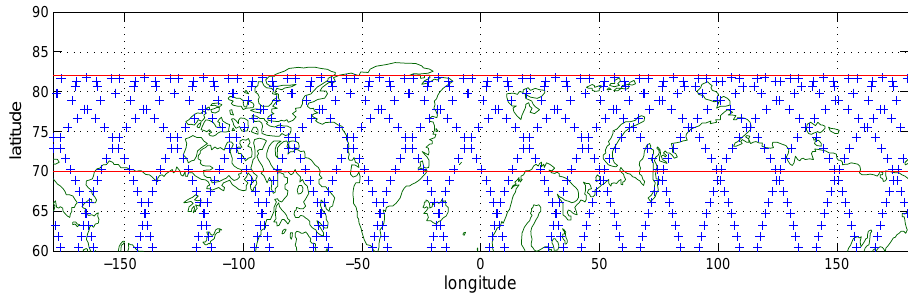
Figure 2. Locations of the MLS profiles for 21 Jan 2006; red lines indicate the zonal band used in this study. Fig. 2. Locations of the MLS profiles for 21 January 2006; red lines indicate the zonal band used in this